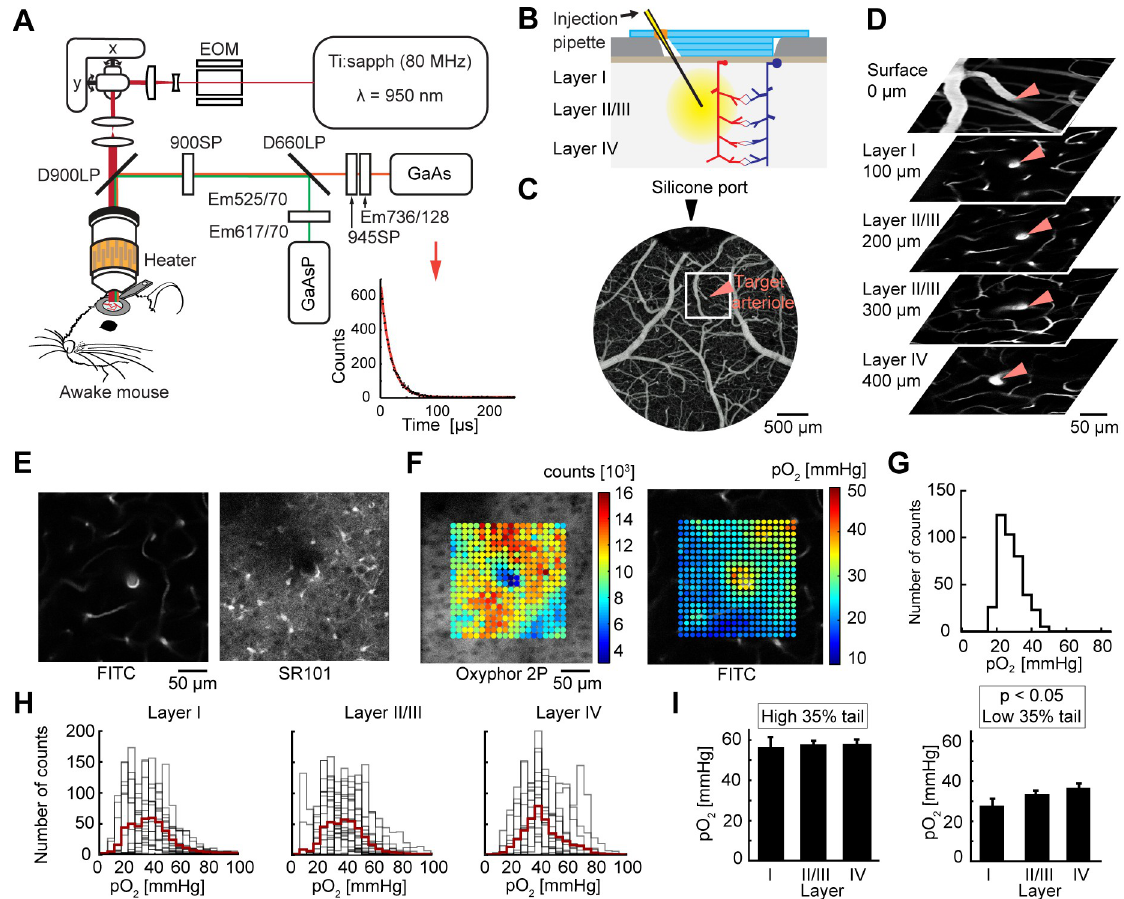
Fig 1. Measurements of tissue partial pressure of O 2 (pO 2 ) across cortical layers of awake mice using 2-photon phosphorescence lifetime microscopy (2PLM). (A) Imaging setup for 2PLM in awake, head-restrained mice. Ti:sapph (80 MHz)—femtosecond pulsed laser tuned to 950 nm; EOM—electro-optic modulator; D900LP and D660LP—long-pass dichroic mirrors with a cutoff at 900 and 660 nm, respectively; GaAsP—photomultiplier tubes; 900SP and 945SP—short-pass optical filters with a cutoff at 900 and 945 nm, respectively; Em525/70, Em617/70, Em736/128—bandpass emission filters. The inset in the lower right corner illustrates a phosphorescence decay; data (black) and fit (red) are overlaid. (B) Schematics of the chronic cranial window with a silicone port for intracortical injection of Oxyphor 2P. (C) An image of surface vasculature calculated as a maximum intensity projection (MIP) of a 2-photon image stack 0–300 μ m in depth using a 5 × objective. Individual images were acquired every 10 μ m. Fluorescence is due to intravascular fluorescein isothiocyanate (FITC). Scale bar = 500 μ m. (D) An example set of images tracking a diving arteriole throughout the top 400 μ m of cortex (red arrowheads). Fluorescence is due to intravascular FITC. Scale bar = 50 μ m. (E) A measurement plane 200 μ m deep including intravascular FITC (left) and sulforhodamine 101 (SR101)–labeled astrocytes (right) for the same arteriole as in (D). Scale bar = 50 μ m. (F) A square measurement grid of 20 × 20 points obtained from the imaging plane shown in (E). Left: photon counts are overlaid on the image of phosphorescence. Right: calculated pO 2 values superimposed on a vascular FITC image. Scale bar = 50 μ m. (G) Histogram of pO 2 values corresponding to (F). (H) pO 2 histograms across cortical layers for all 11 arterioles from 8 animals. Each panel shows overlaid histograms from each measurement plane (gray) and superimposed average (red). (I) Quantification of the top and bottom 35% of the pO 2 distributions from (H). Error bars show standard error calculated using a mixed effects model implemented in R ( p > 0.1 for the top 35% and p < 0.05 for the bottom 35%). Numerical values for (G–I) are provided in S1 Data (sheets 1G–1I).